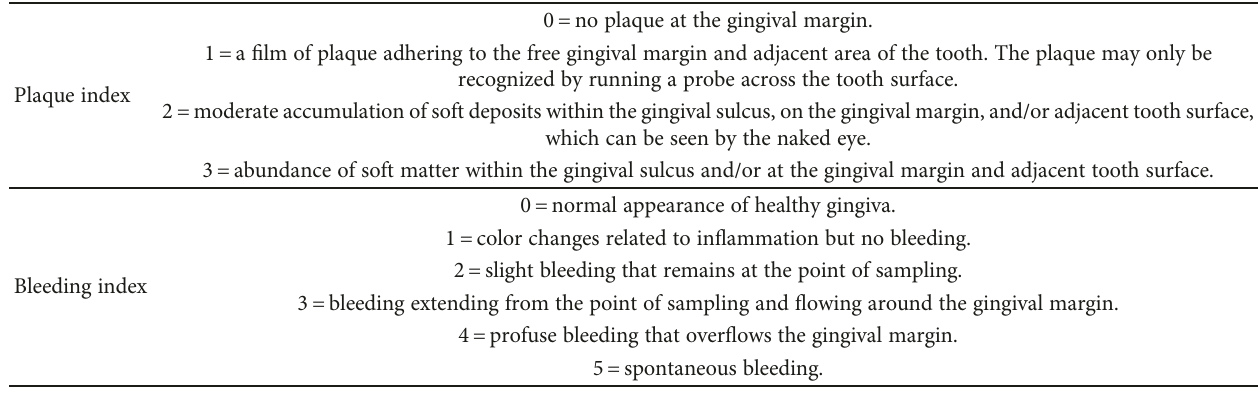
Table 1: Description of clinical diagnostic criteria for plaque and bleeding indices.